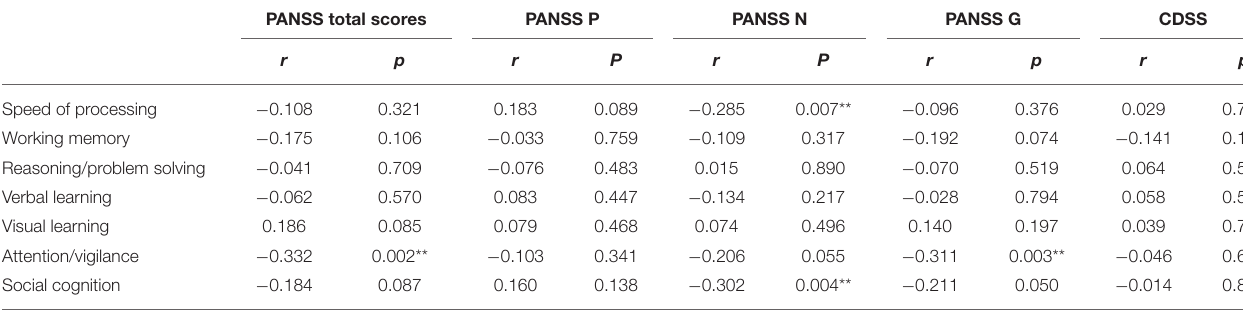
TABLE 3 | Correlation between clinical characteristics and cognitive dysfunction. PANSS total scores PANSS P PANSS N PANSS G CDSS r p r